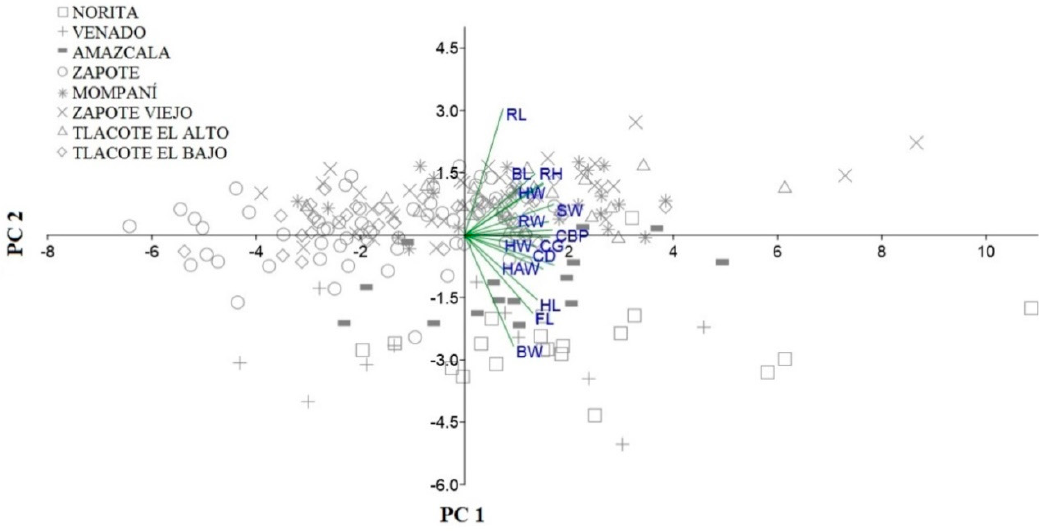
Figure 3. Principal components analysis of fourteen morphometric variables in the Black Creole goat from eight localities in central Mexico. (HW) head width, (HL) head length, (FL) face length, (WH) wither height, (CG) chest girth, (BL) body length, (BW) bicostal width, (CD) chest depth, (SW) shoulder width, (RL) rump length, (RW) rump width, (HAW) haunch width, (RH) rump height, (CBP) cannon bone perimeter.